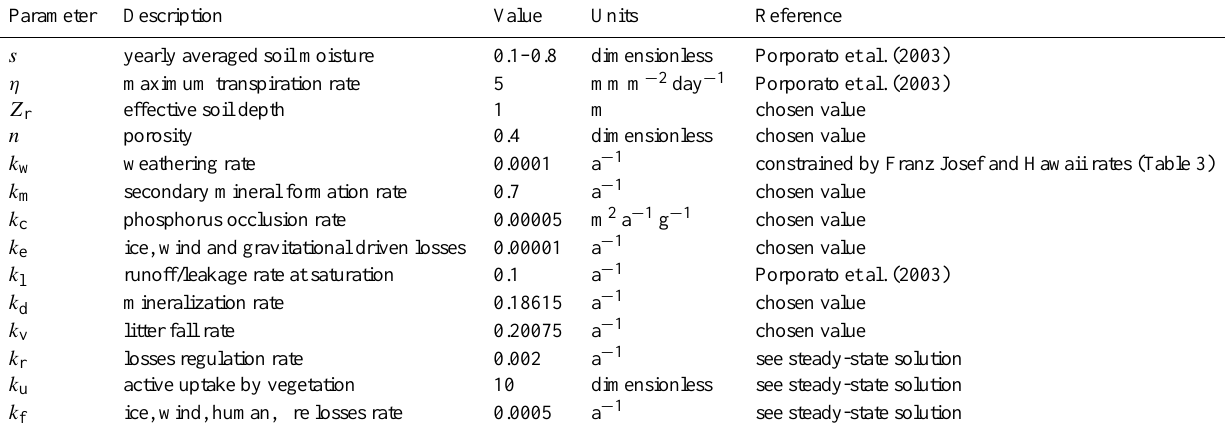
Table 2. Description of model